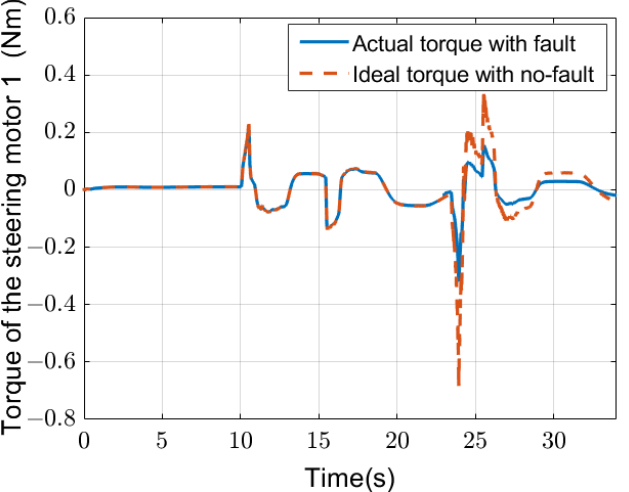
Figure 5. Torque of Steering actuator 1 (Blue line: the actual steering torque with faults; red dotted line: the ideal steering torque with